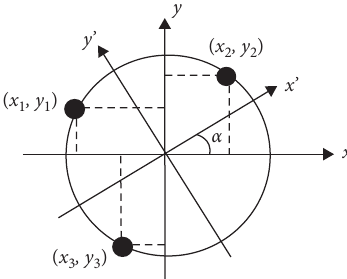
Figure 3: Pipeline cross section with VWGs point